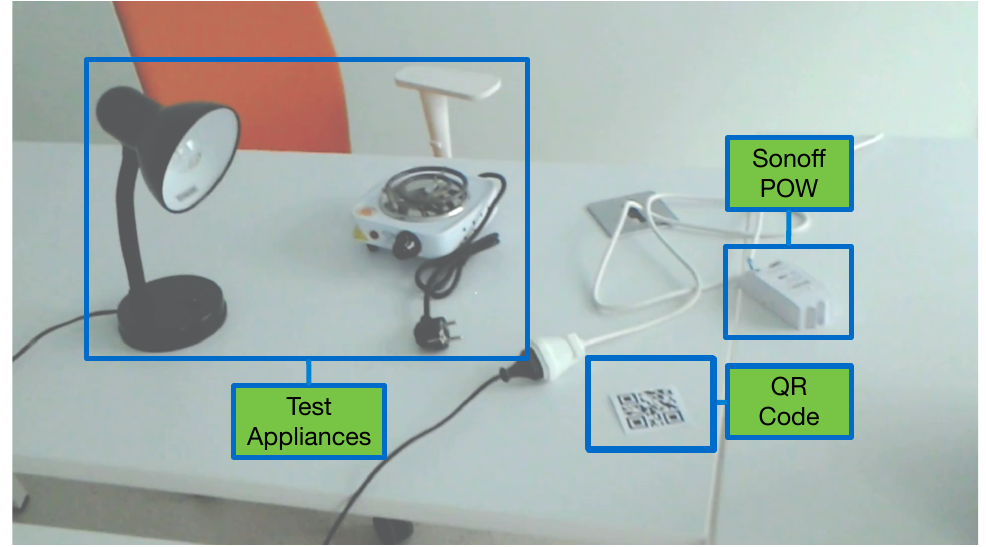
Figure 6. Smart socket